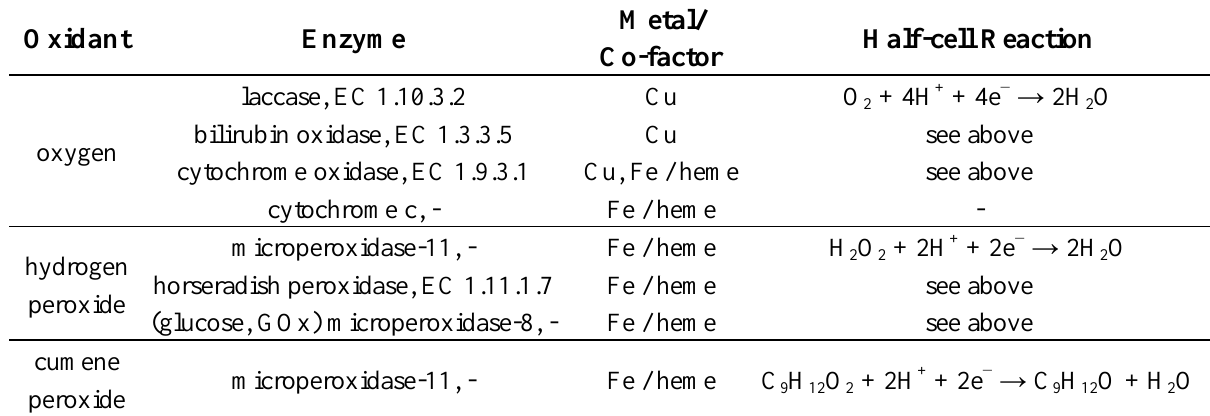
Table 2. Oxidants and enzymes used in enzymatic biofuel